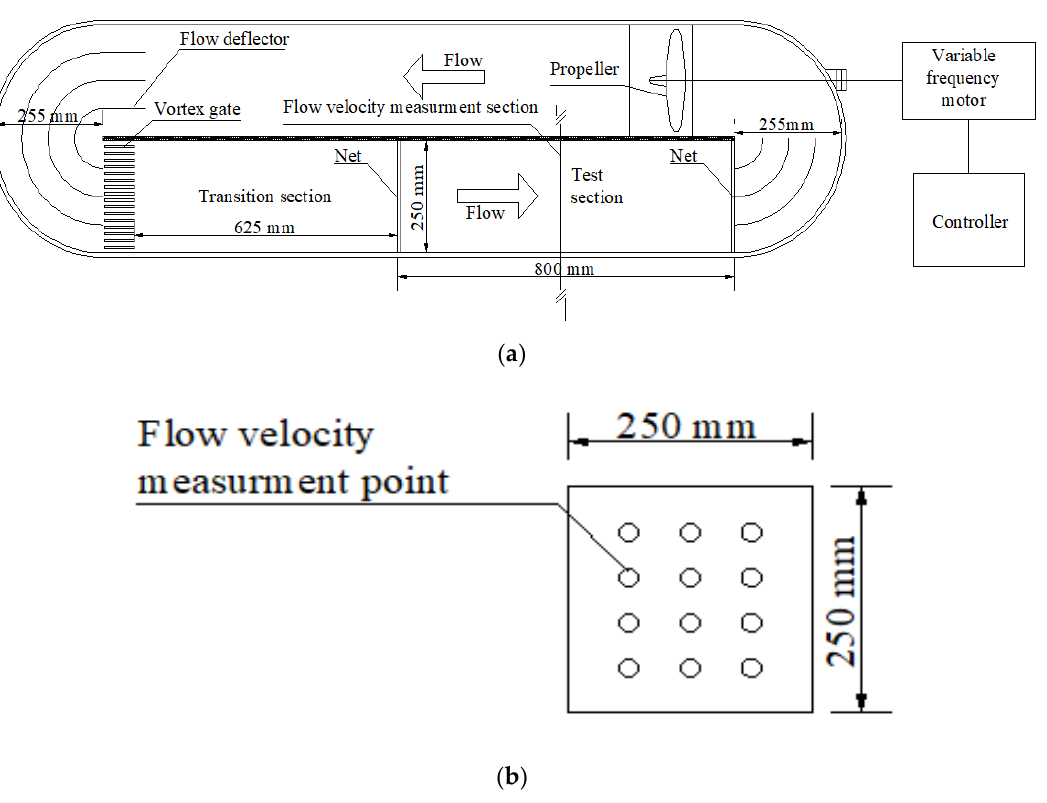
Figure 1. Illustration of test water tank. ( a ) Plane graph of test water tank; ( b ) Cross section of water velocity measurement.